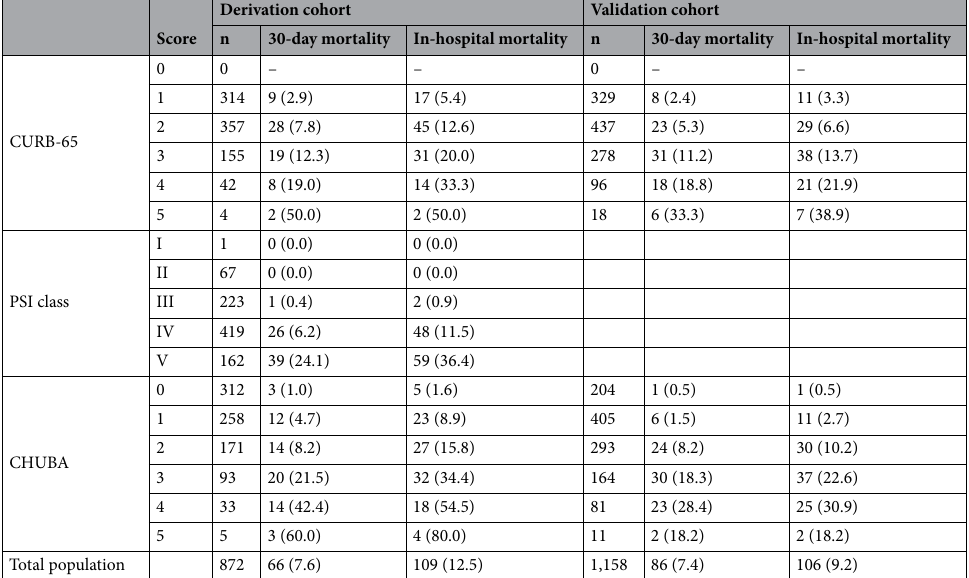
Table 4. Comparison of conventional and new prognostic scoring in the derivation and validation cohorts. Data are presented as n (%). CURB-65, confusion, urea, respiratory rate, blood pressure, age ≥ 65; PSI, pneumonia severity index; CHUBA, confusion, hypoxemia, urea, bedridden,